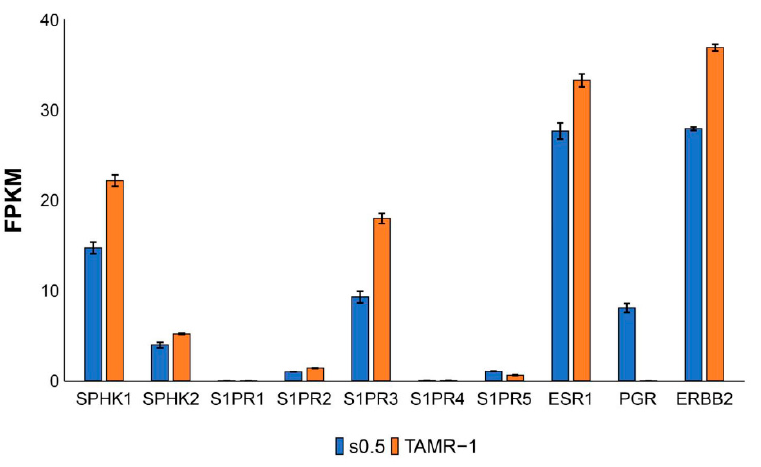
Figure 3. Expression levels of S1P-related genes, ESR1, PGR, and HER2, on wildtype MCF-7 cells (MCF-7/S0.5) and tamoxifen-resistant MCF-7 cells (MCF-7/TAMR-1). Expression levels of S1P-related genes, ESR1, PGR, and HER2, were assessed by RNA-seq. Data are shown as means ± SE.